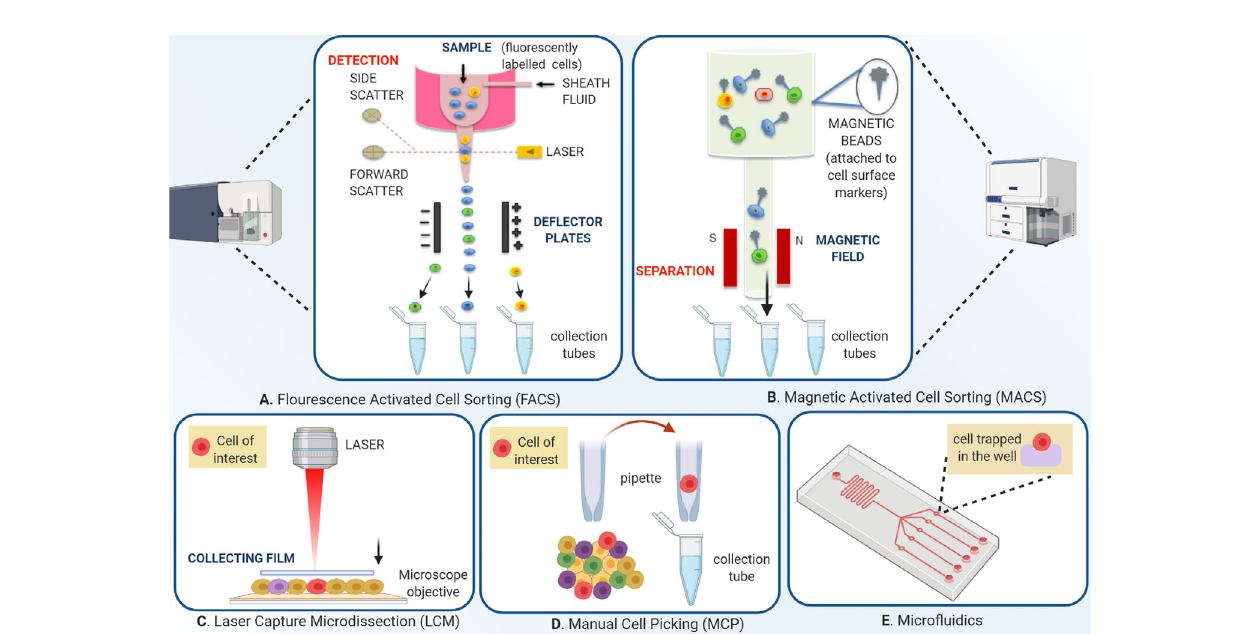
FIGURE 2 | Overview of single-cell isolation technologies. (A) Schematic of fl uorescence-activated cell sorting; FACS employs two separate techniques, streamlining the fl uorescently labeled cells to pass through a micro-spectrophotometer one cell at a time, and a second to record the emission of the signal. The signals are based on cell dimensions, coarseness, and fl uorescence. The technique allows both qualitative and quantitative analysis of a cell population. After the initial sample preparation, the cell suspension is passed in a monolayer in a manner that each cell is subjected to exposure by a laser which permits the fl uorescent labels to be identi fi ed by the instrument. The instrument applies a charge depending on the nature of the cell, which de fl ects a droplet containing the cell of interest from the entire fl ow. This charged droplet is then collected by collection tubes. (B) Magnetic-activated cell sorting differs from FACS in the way that instead of fl uorophore tagged labels, this technique uses magnetic bead conjugated with antibodies, streptavidin, lectins, or enzymes. The cells are channelized under an applied magnetic fi eld that allows non-conjugated cells to pass freely. The magnetic bead conjugated cells are then eluted by turning the magnetic fi eld off. Separation can be both positive and negative. Positive separation employs a technique where the cells of interest are conjugated with the magnetic beads. (C) Laser capture micro- dissection uses an inverted microscope, an infrared or ultraviolet laser, and an extraction system. After visual identi fi cation of the cell of interest, through a user- de fi ned pattern, the laser cuts the cell from the population. Various extraction methods are used, one of them being the laser activating an adhesive on a thin fi lm kept over the tissue, which in turn sticks to the cell of interest, and the cell can be removed by picking up the fi lm. (D) Manual cell picking also employs an inverted microscope, but instead of lasers, automated micropipettes are used for the cell extraction. MCP ’ s main advantage over LCM is that live cell cultures can be isolated, in contrast to fi xed cells in LCM and (E) A micro fl uidic device depends on the capture of single cells from the suspension so well diluted that the probability of one cell going into one well is maximum. The microwell technique can accommodate single-cell imaging along with analysis. Automated devices streamline the cells in a micro fl ow and sort the cells according to speci fi c properties like size, charge, or ligand af fi nity into different